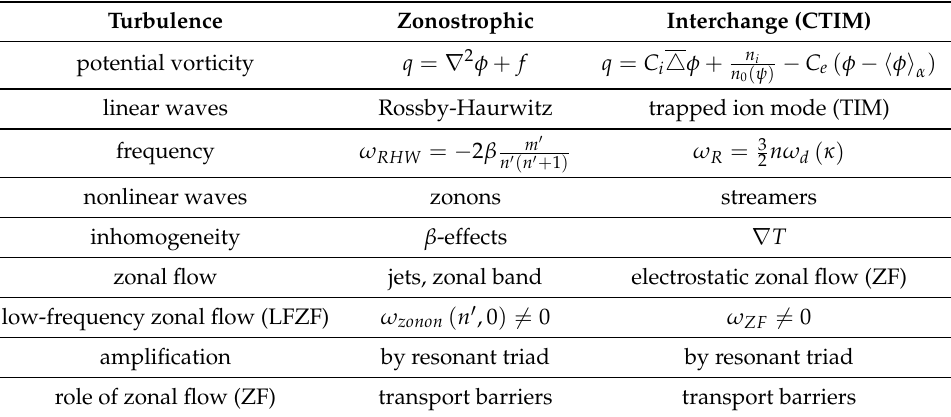
Table 1. Summary of different types of waves and coupling processes in both interchange-type turbulence and zonostrophic